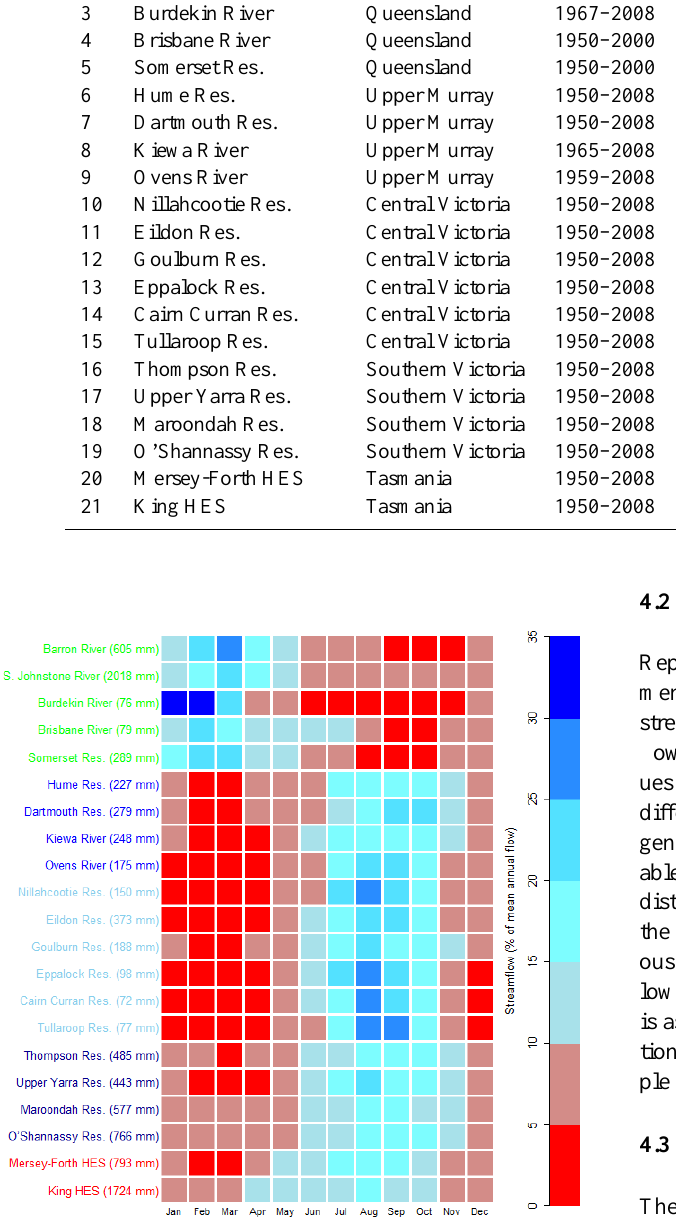
Fig. 2. Plot of streamflow seasonality for all catchments. (Mean an- nual flow is provided following the catchment